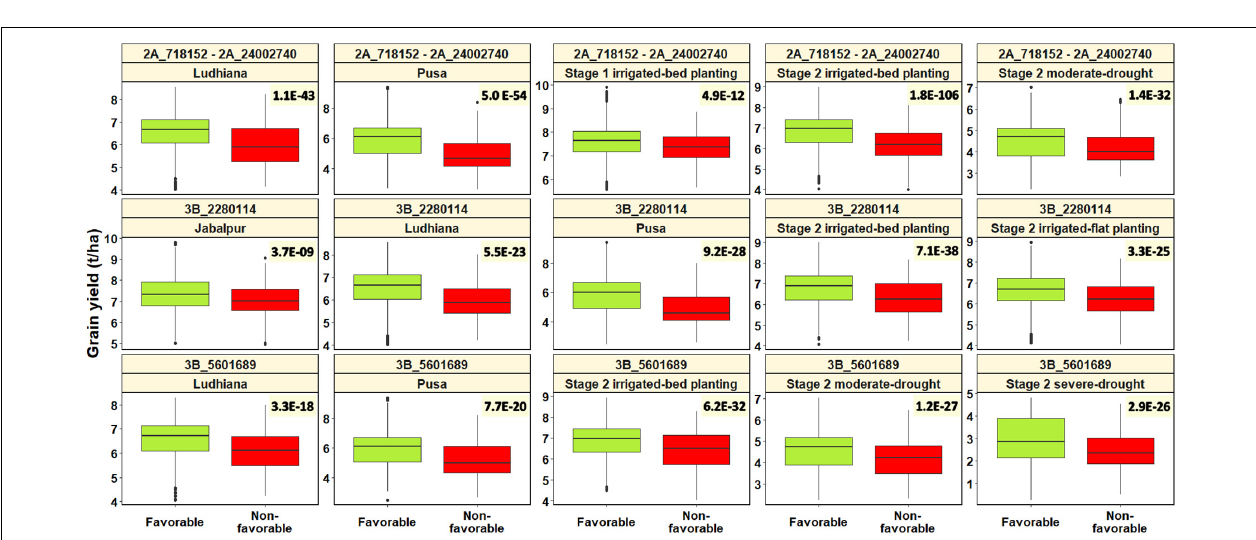
FIGURE 7 | Spot blotch favorable alleles (alleles that have a decreasing effect on spot blotch) and non-favorable alleles (alleles that have an increasing effect on spot blotch) at linkage disequilibrium block 2A_718152 – 2A_24002740 and markers 3B_2280114 and 3B_5601689 plotted against the grain yield in different environments. The values on the top right of the panels indicate the two-sided t -test p -values for the test that there is no relationship between the spot blotch associated marker alleles and grain yield against the alternate hypothesis that there is a